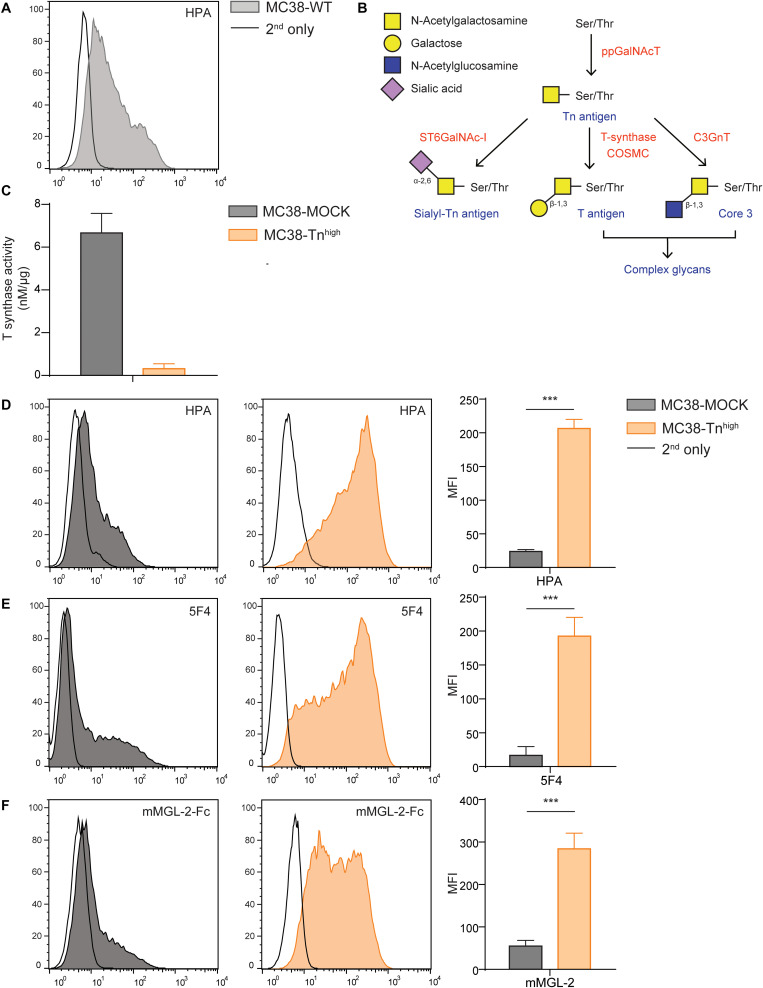
C1galt1c1 knock out in MC38 cells results in high expression of Tn antigen. (A) Expression of Tn antigen on MC38 wild type (MC38-WT) cells analyzed by flow cytometry using the lectin HPA. (B) Simplified representation of the O-glycosylation pathway, adapted from Cornelissen and Van Vliet (29). (C) T synthase enzyme activity measured using the T synthase assay (16) in MC38 cells. (D) CRISPR/Cas9-mediated knock out of C1galt1c1 resulted in increased Tn antigen expression (MC38-Tnhigh) as measured with HPA. As a negative control, MOCK-transfected cells (MC38-MOCK) were used. (E,F) Tn antigen expression measured with an anti-Tn antigen antibody (5F4) (E) or mouse macrophage galactose-type lectin (MGL) 2-Fc protein (mMGL-2-Fc) (F) on MC38 cells. Mean ± SD; MFI, mean fluorescent intensity, ***p < 0.001.